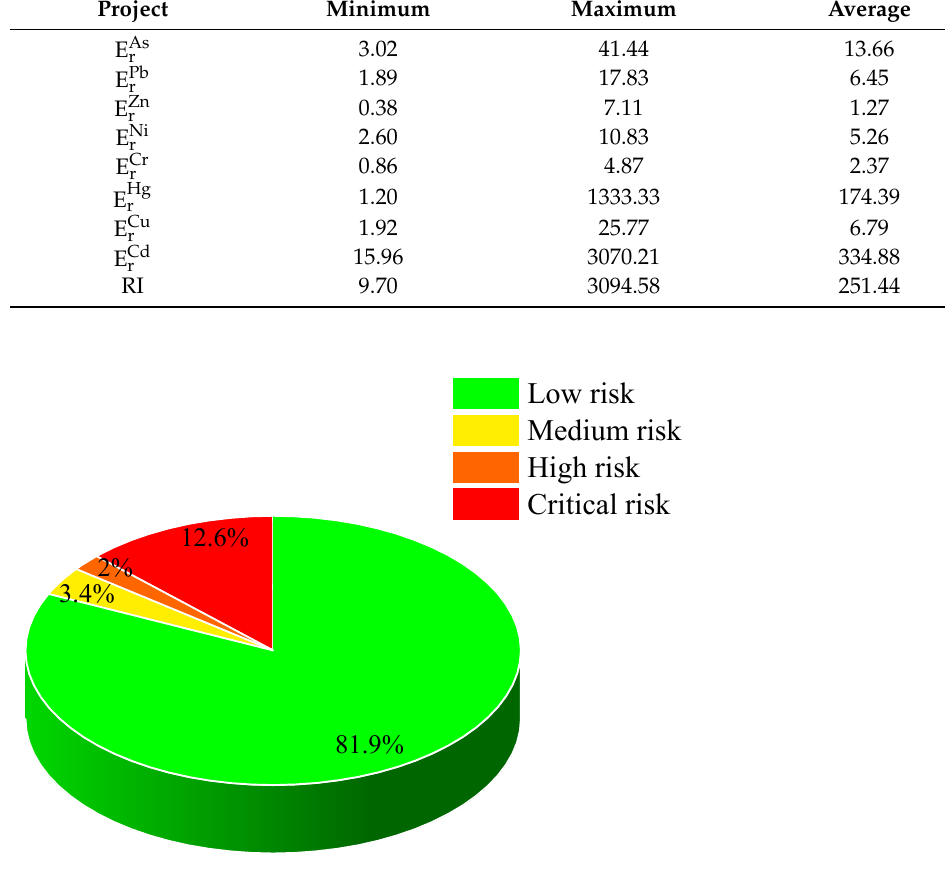
Figure 5. Pie chart of potential ecological risk distribution.